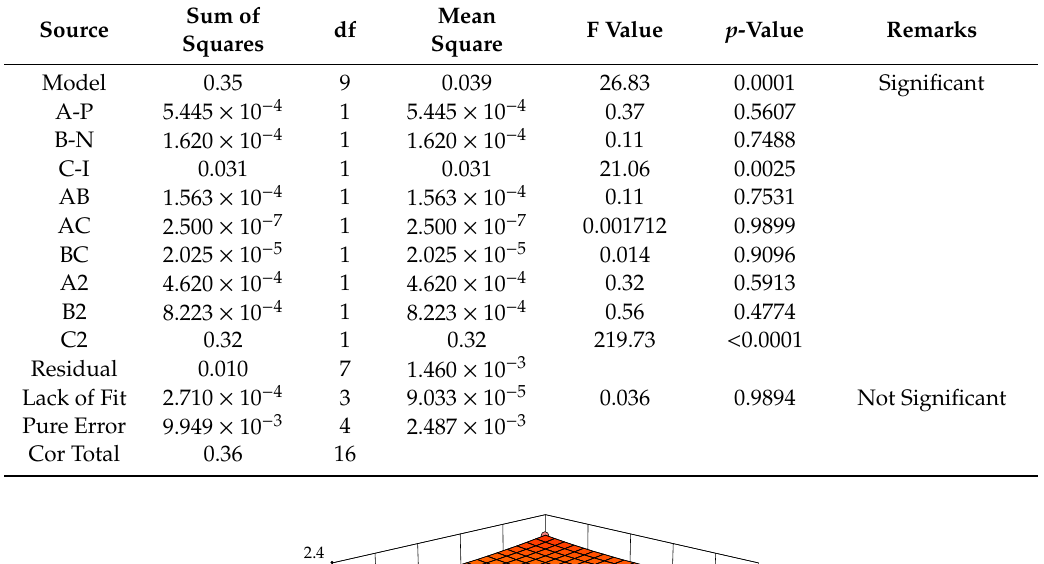
Table 3. ANOVA for the erosion analysis.